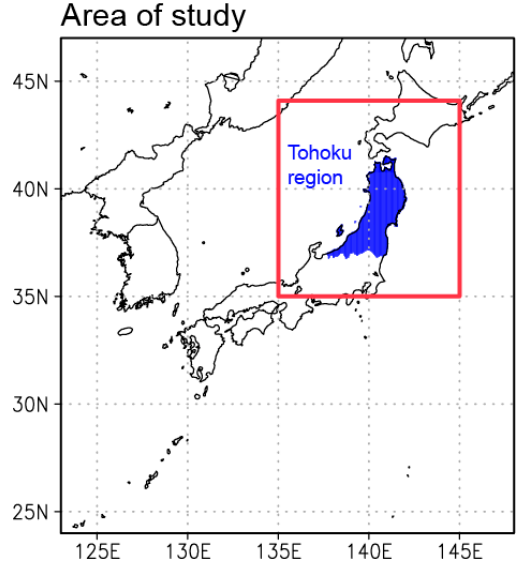
Figure 1. Area of study in East Japan (red solid box) used to define the atmospheric patterns. The blue shading represents the Tohoku region (served by Tohoku Electric Power Co., Inc.), Sendai, Japan.